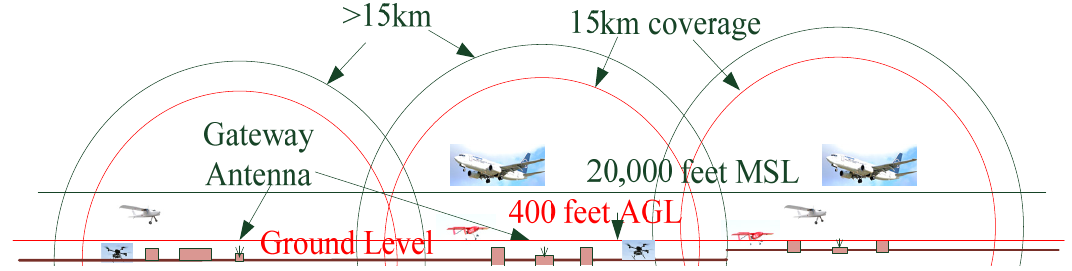
Figure 2. Automatic dependent surveillance-broadcast (ADS-B) like ground transceiver station (GTS) deployment in Southern Taiwan (red small circle for long-range wide area network (LoRa), blue large circle for automatic packet reporting system (APRS), CJCU at X , where rectangle enclosing Tainan City).